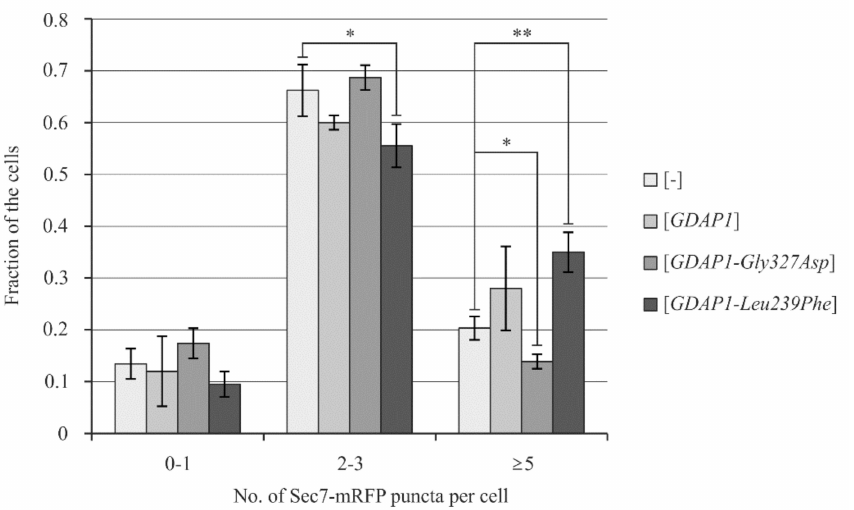
Figure 6. The expression of GDAP1 variants in yeast cells influences localization of Sec7-mRFP, the trans - Golgi network marker protein. Yeast cells carrying the SEC7-mRFP -containing plasmid were observed using confocal microscopy. The number of Sec7-mRFP puncta in a single cell was determined. Error bars represent standard deviation for three repeats. Statistical analysis was performed on data from three